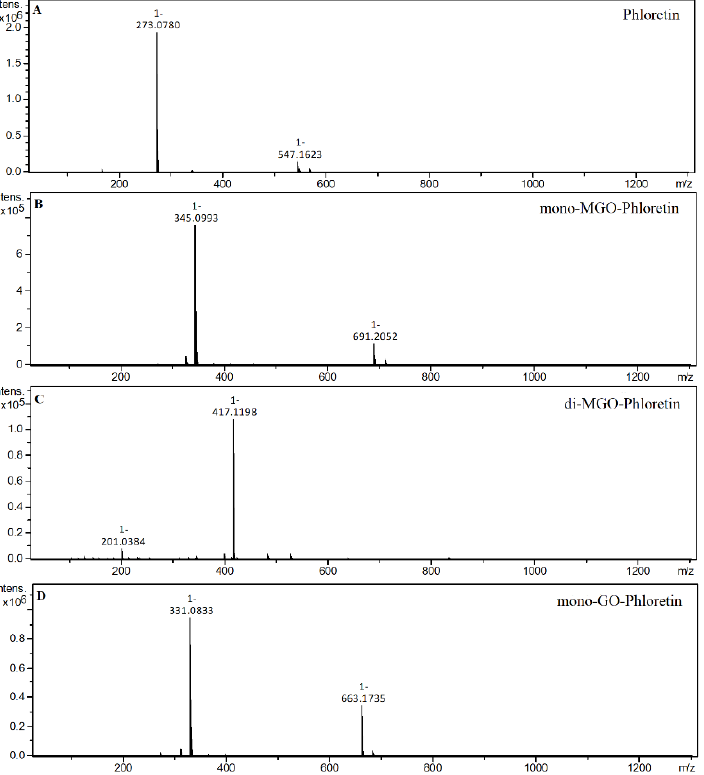
Figure 4. Mass spectra of phloretin and its methylglyoxal/glyoxal adducts after 1 h of incubation in pH 7.4 phosphate buffer solution at 37 °C; ( A ), phloretin; ( B ), mono-MGO-phloretin; ( C ), di-MGO- phloretin; ( D ), mono-GO-phloretin. Other isomers are also possible.